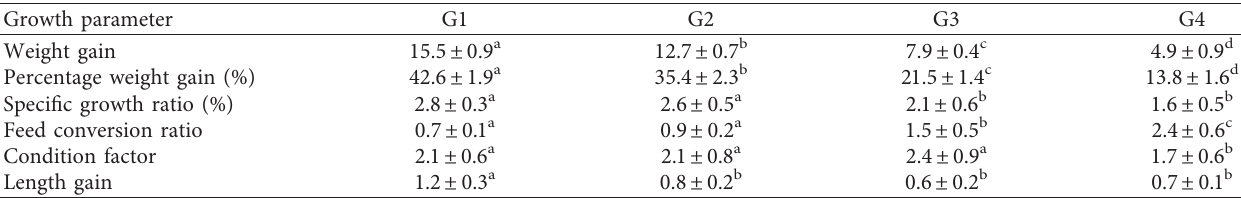
Table 3: Growth parameters: G1 (control), G2 (AsNPs 1mg/l), G3 (AsNPs 10mg/l), and G4 (AsNPs 20mg/l). Values with a different superscript in the same row are significantly different.